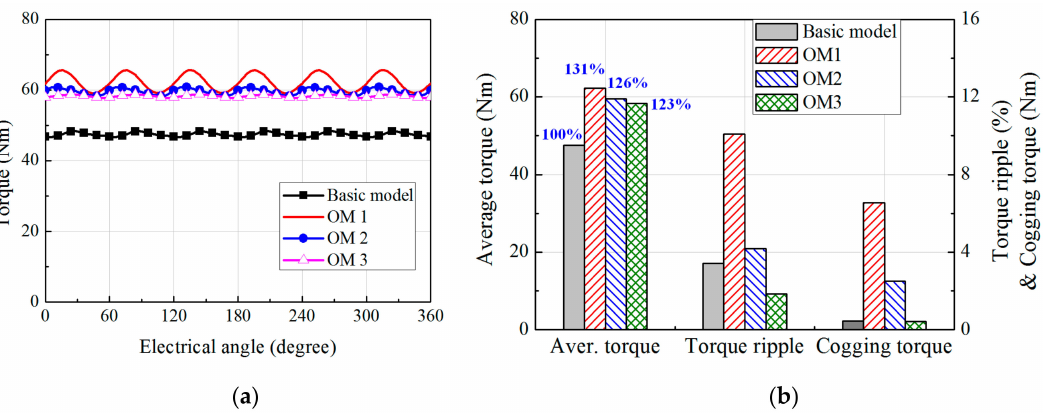
Figure 13. Torque characteristics of the basic and optimal models. ( a ) Waveforms; ( b ) Torque characteristics.